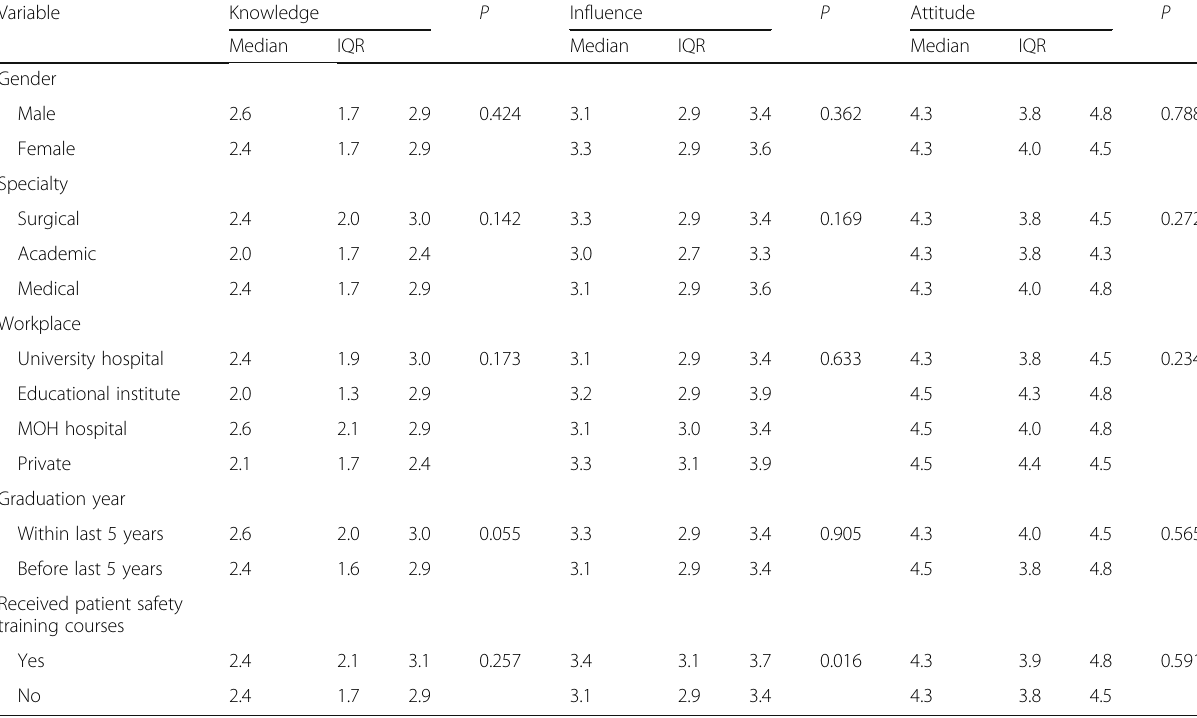
Table 5 Relation between personal characteristics and knowledge, influence, and attitude scores among participated physicians Variable Knowledge